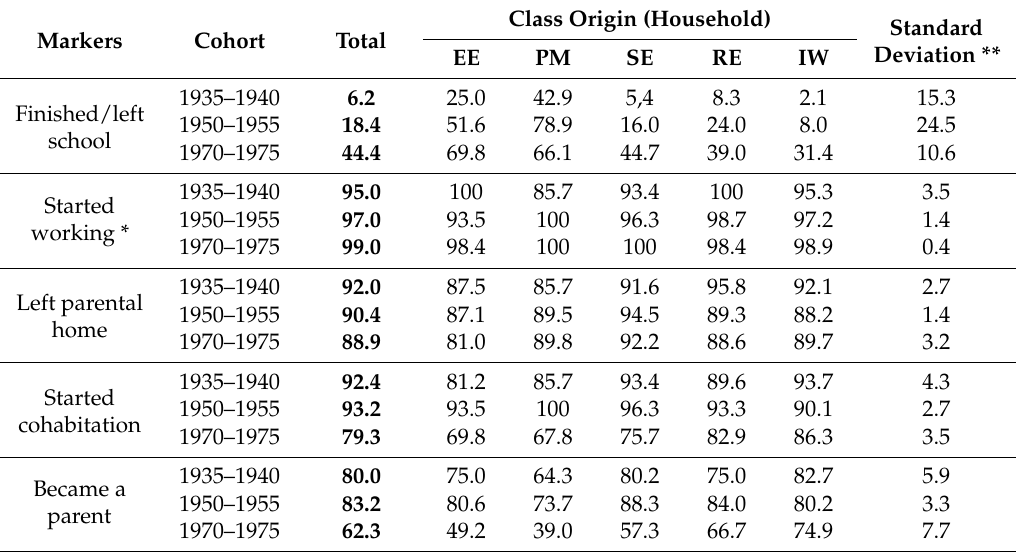
Table 6. Percentage of individuals that completed a transition at 30 years of age by social class